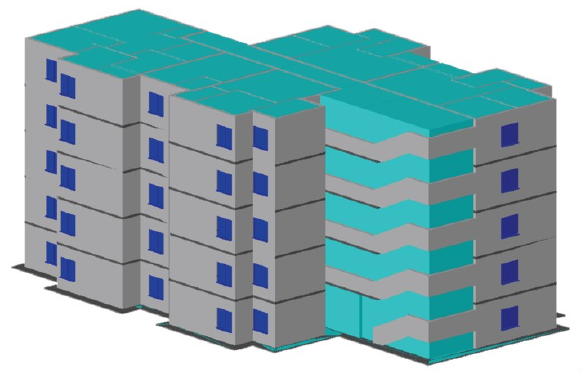
Figure 14. Result of method